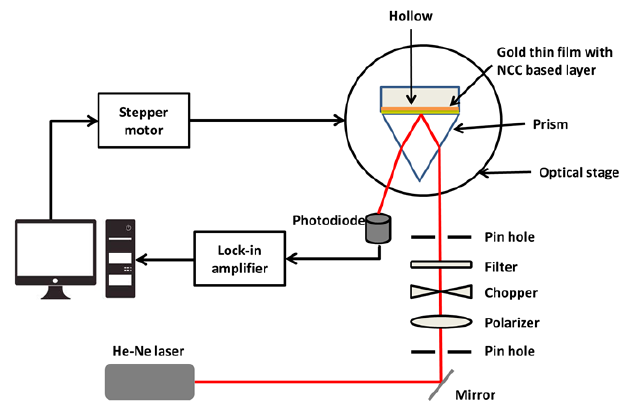
Figure 2. Optical setup of surface plasmon resonance spectroscopy with nanocrystalline cellulose (NCC)-based thin film.